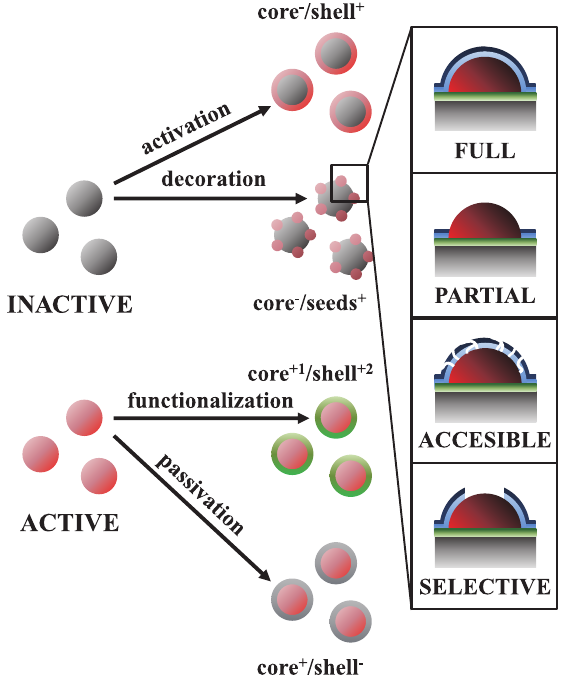
Fig. 2 Functionalization possibilities for active and inactive particles by film or cluster deposition via